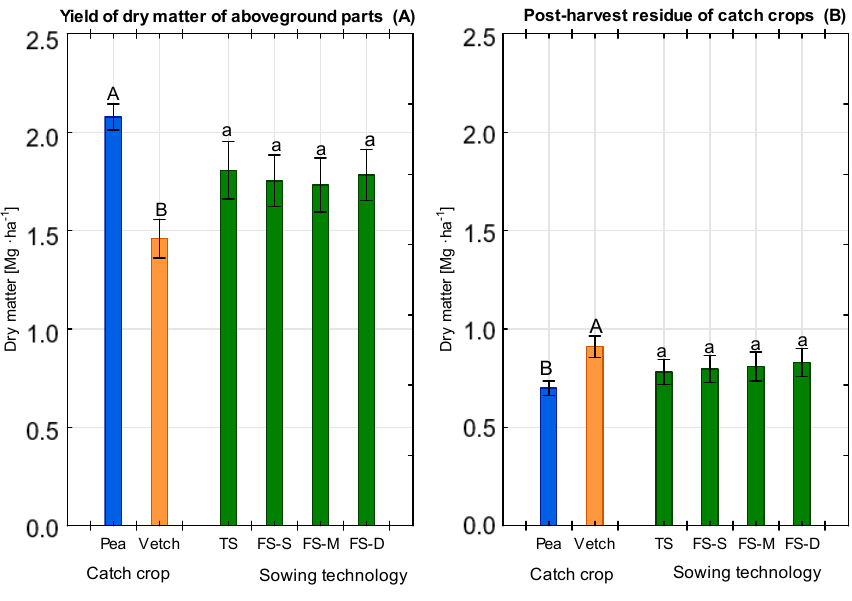
Figure 9. Interaction between factors in shaping the plant density 15 days after sowing seeds [pcs. m − 2 ]. a,b—homogenics groups HSD ( p = 0.05) interaction for sowing method/species (the differences between the four methods of sowing separately for pea and for vetch). A,B—homogenic groups HSD ( p = 0.05) interaction for species/sowing method (differences between pea and vetch for each sowing method).